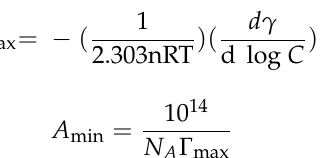
Figure 1. Surface tension ( γ LV ) versus the concentration for the extended surfactants. The saturated adsorption amount ( Γ max ) and saturated adsorption area ( A min1 ) can be calculated by Gibbs equations as follows